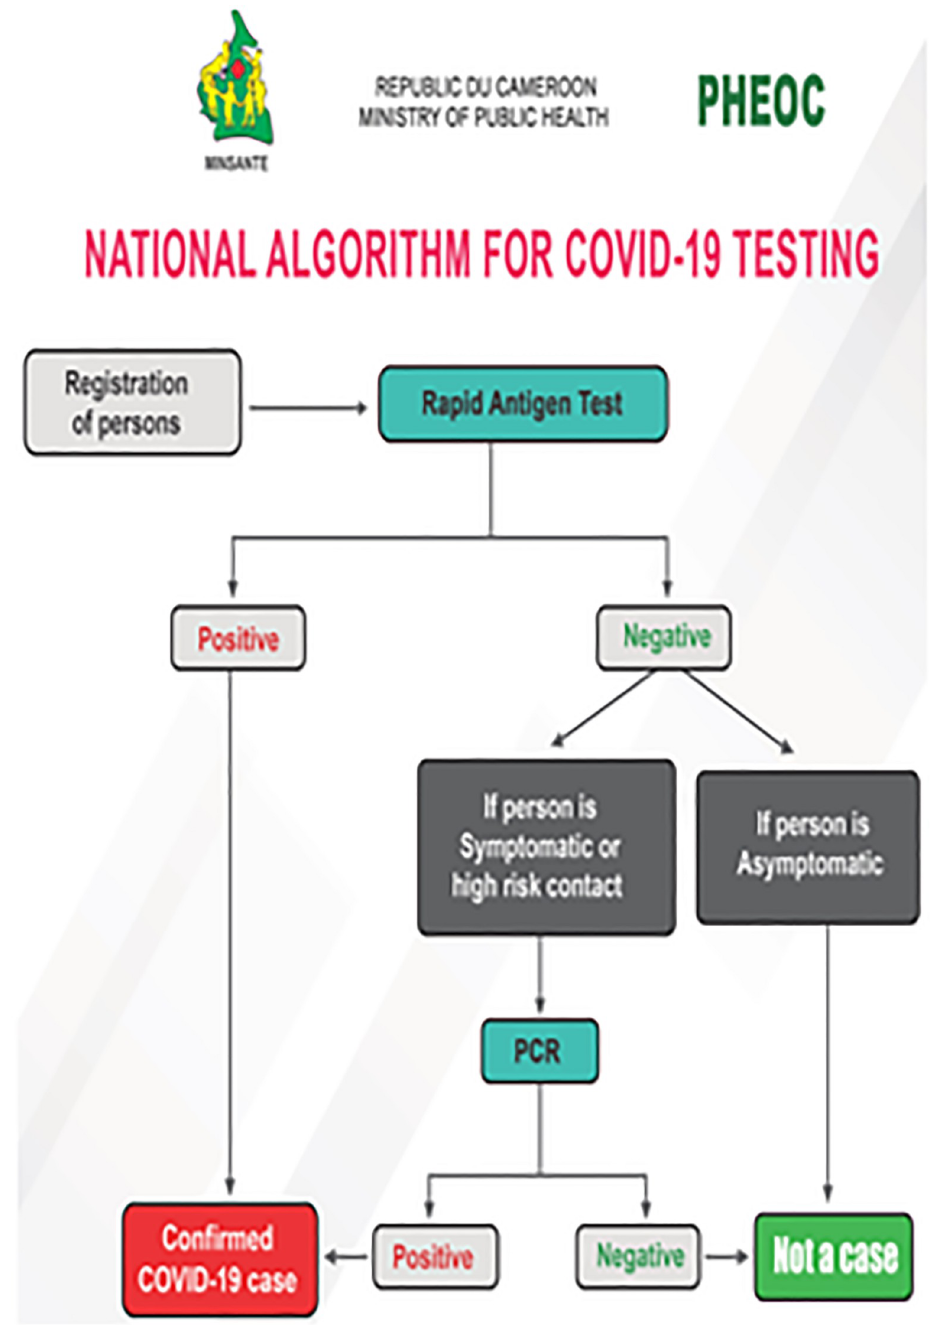
Fig 2. Standard algortihm for routine COVID-19 testing in Cameroon. COVID-19: Coronavirus Disease 2019.